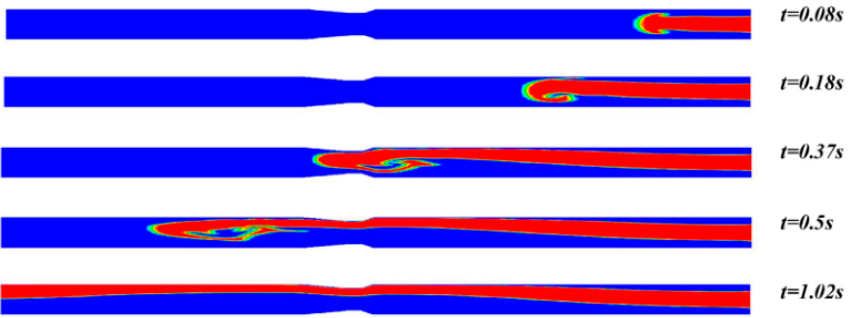
Figure 8. Development of CAF [38]. (Red for oil and blue for water. The expansion angle and inclination angle are 3.7° and 0°, respectively.)